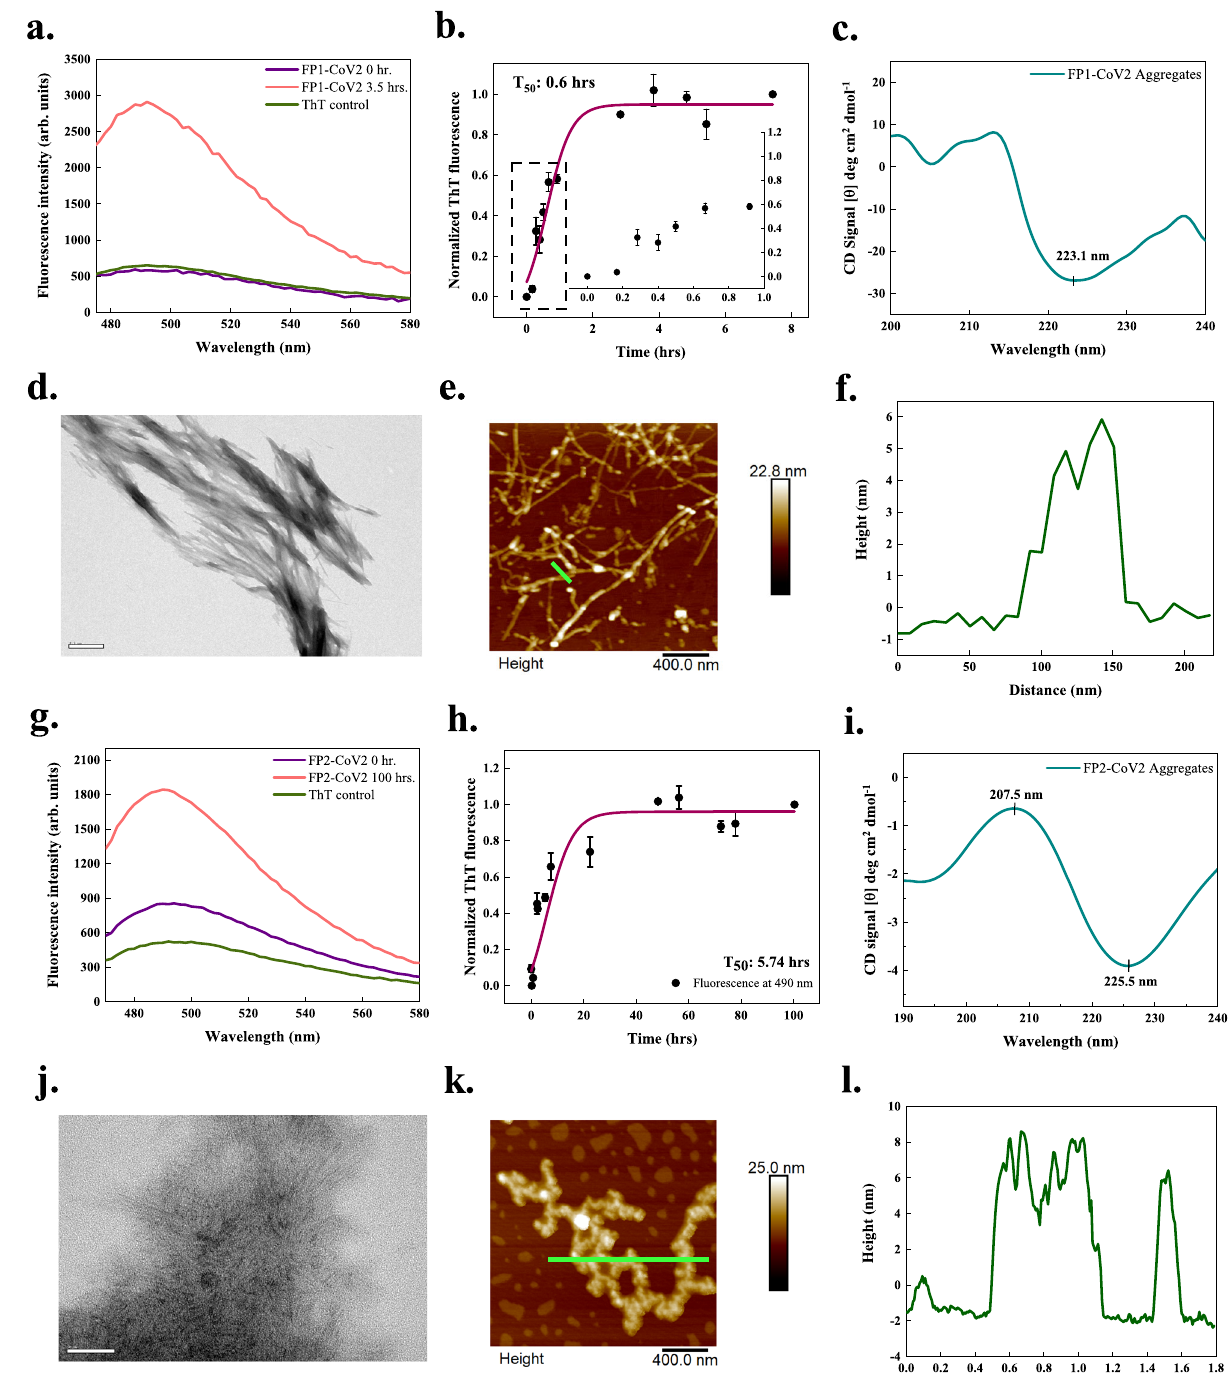
Fig.4|Invitroaggregationoffusionpeptides1(FP1-CoV2)and2(FP2-CoV2)of theSARS-CoV-2Sprotein.a , g ThT fl uorescencescan( λ ex 440nm)showsa~6-and ~2-fold increment at λ max with FP1-CoV2 and FP2-CoV2 incubated samples, respectively. b , h Aggregation kinetics monitored using ThT fl uorescence. Each dotted symbol represents the average value of two technical replicates and error bar represents the SEM of these replicates. The wine-coloured lines show the sig- moidal fi ttings of data points that determines the T 50 values as 0.6±NC h and 5.74±NChforFP1-CoV2andFP2-CoV2peptides,respectively.Thekineticsreaction of FP1-CoV2 shows a very short lag phase that can be seen in the inset. c , i The secondary structure of 1mg/ml peptides (both incubated for 240h) investigated using CD spectroscopy shows a negative peak at ~223 and ~225nm. The spectral data of FP1-CoV2 and FP2-CoV2 aggregates are smoothened with 4 and 10 points